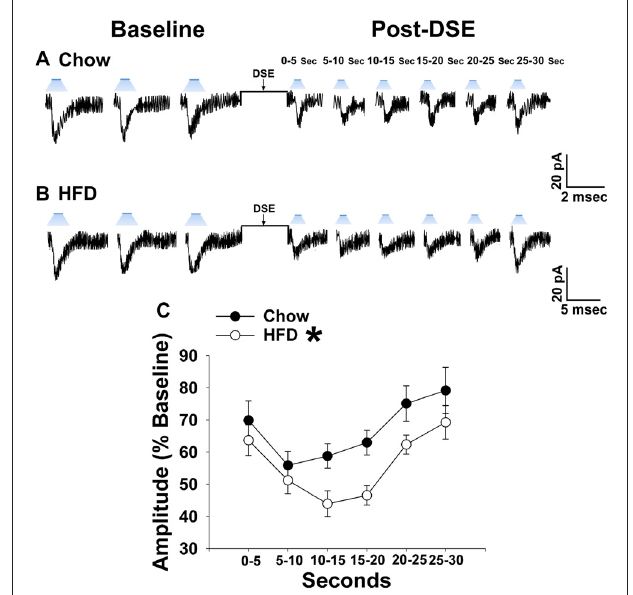
FIGURE 9 | The postsynaptic depolarization-induced reduction in leEPSC amplitude seen in chow-fed males is even further reduced in HFD-fed animals. (A) Representative membrane current trace illustrating that the eEPSC amplitude is reduced post DSE in chow-fed animals ( n = 22). However, this effect is significantly enhanced in animals fed a HFD ( B ; n = 19). A composite line graph showing how the reduction in leEPSC amplitude caused by postsynaptic depolarization is significantly augmented (C) . Lines represent means and vertical lines 1 SEM. ∗ P < 0.05; rank-transformed multifactorial